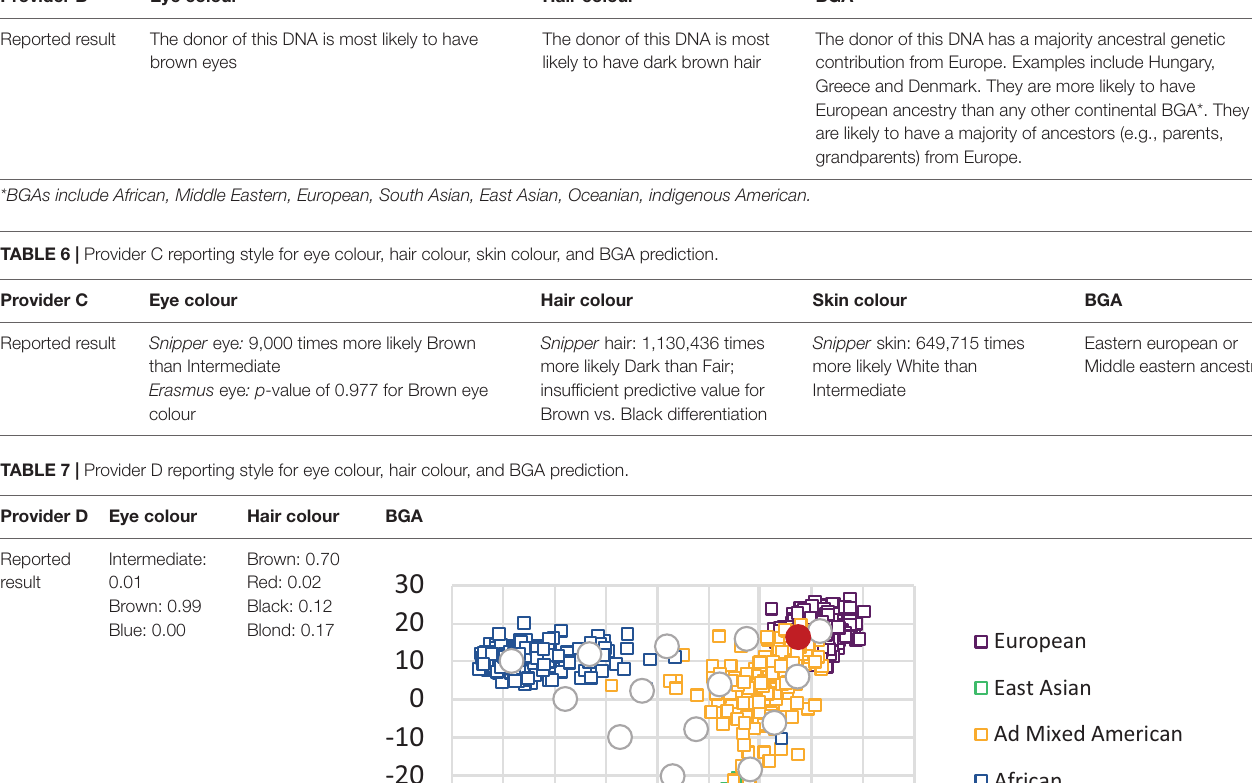
TABLE 5 | Provider B reporting style for eye colour, hair colour, and BGA prediction. Provider B Eye colour